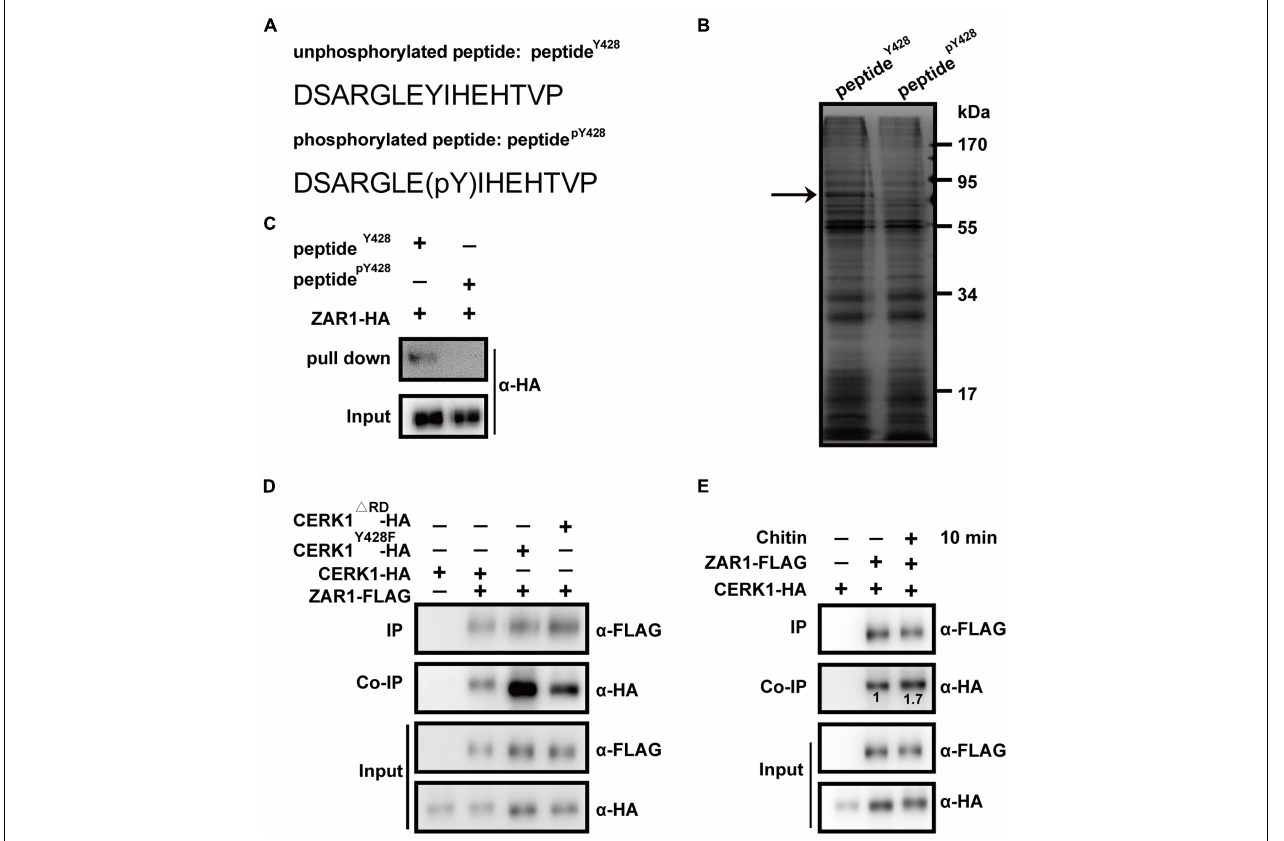
FIGURE 1 | Zygotic arrest 1 (ZAR1) interacts with chitin elicitor receptor KINASE 1 (CERK1) depending on the dephosphorylation of Y428 residue and functions in defense against Botrytis cinerea. (A) Two “bait” peptides, peptide pY428 fragment “DSARGLE(pY)IHEHTVP” and peptide Y428 fragment “DSARGLEYIHEHTVP” was designed via the web-based motif-x program (http://motif-x.med.harvard.edu/). (B) Sodium dodecyl sulfate-polyacrylamide gel electrophoresis (SDS-PAGE) analysis of differential peptide-pulling down (PPD) proteins. After the PPD assay, the peptide Y428 beads-binding proteins and peptidep Y428 beads-binding proteins were analyzed with SDS-PAGE and followed by silver staining. The differential protein bands were observed. The differential band was illustrated with an arrow. (C) Pulling-down of ZAR1 protein with peptide Y428 beads. The HA-tagged ZAR1 protein expressed in Arabidopsis protoplasts was incubated with peptide Y428 beads, and the pulling-down proteins were detected by immunoblotting using an anti-HA antibody. Total protoplast proteins were used as input. The experiments were repeated three times with similar results. (D) Co-immunoprecipitation (co-IP) of ZAR1 and entire CERK1 protein. FLAG-tagged ZAR1 with HA-tagged CERK1 Y428 F , FLAG-tagged ZAR1 with CERK1 (cid:49) RD , or FLAG-tagged ZAR1 with wild type CERK1 was co-expressed in Arabidopsis protoplasts for 12 h, respectively. CERK1 Y428 F and CERK1 (cid:49) RD protein showed enhanced interaction with ZAR1 protein. The experiments were repeated three times with similar results. (E) Interaction between ZAR1 and CERK1 was influenced by chitin elicitation. HA-tagged CERK1 and FLAG-tagged ZAR1 were co-expressed in protoplasts for 12 h, then the co-IP was performed before chitin treatment or after 10 min of chitin treatment. Numbers indicate relative amounts of CERK1-HA co-immunoprecipitated with ZAR1-FLAG, measured using the ImageJ program. The experiments were repeated three times with similar results.